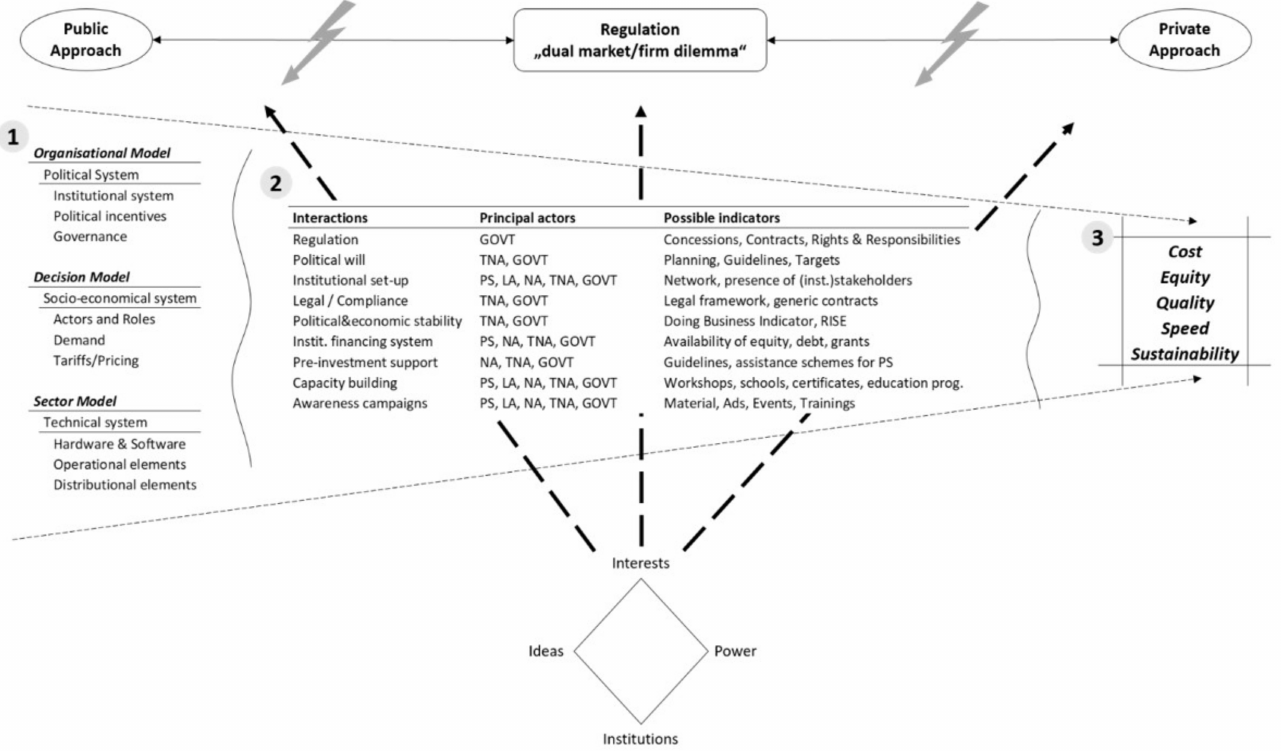
Figure 1. Political economy framework and research tool for electricity